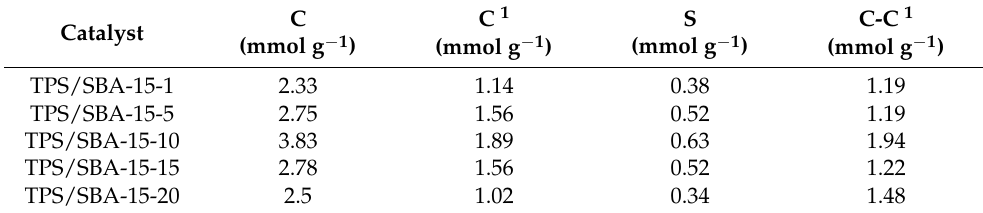
Table 2. Results of elemental analysis and concentration of SO 3 H species.